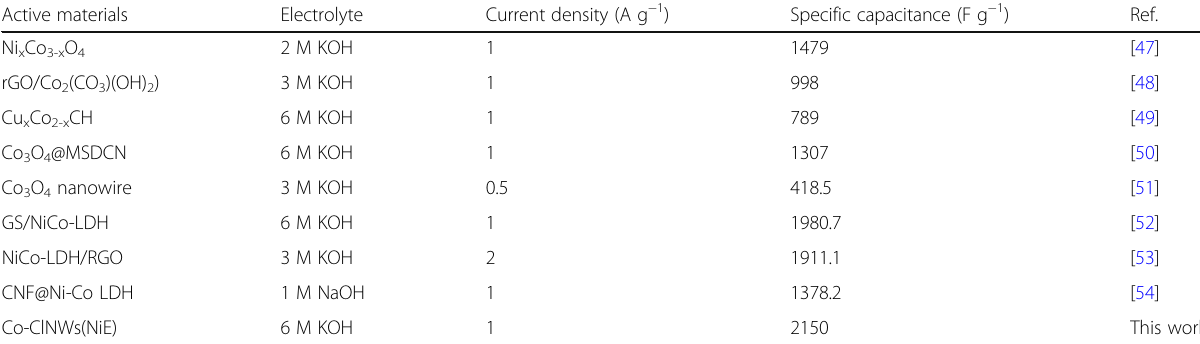
Table 1 Comparison of the performance of our work with the literatures based on three-electrode system Active